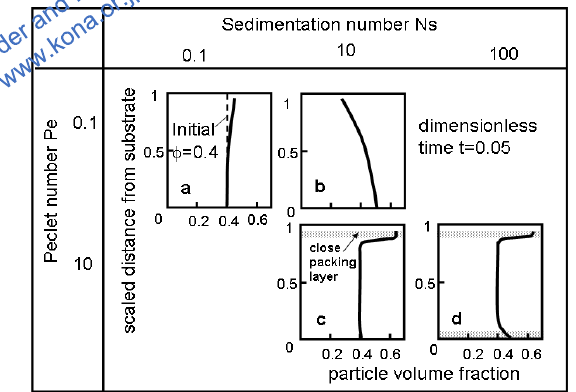
Fig. 5 Drying regime map 22)